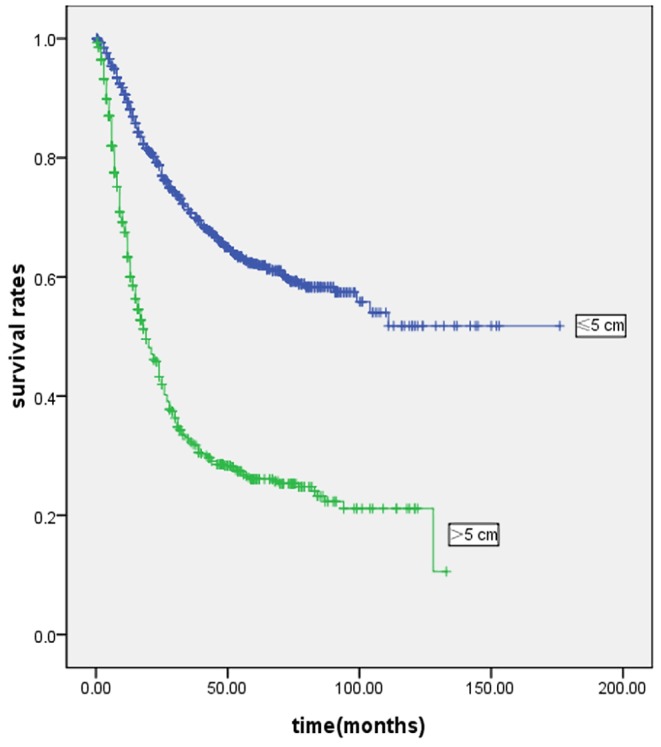
Kaplan-Meier survival curves in all underwent gastrectomy patients according to tumor size (n = 1800).Prognosis of larger tumor size was worse than smaller tumor size in patients with gastric cancer (P<0·001). Five-year survival rates were 26.1% and 62.1% in LSG and SSG, respectively.